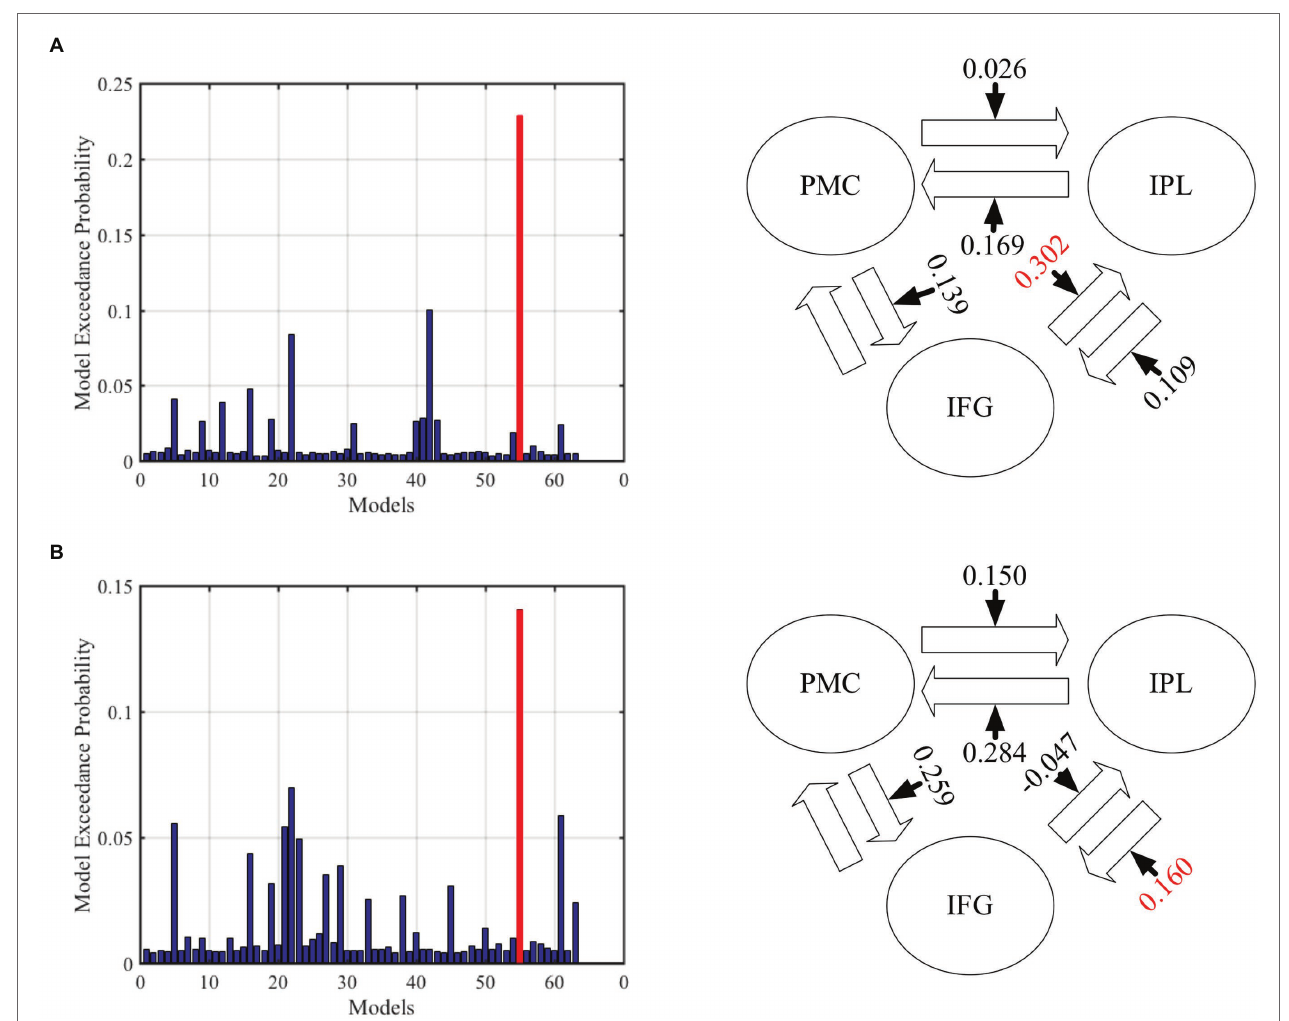
FIGURE 6 | Results of dynamic causal modeling (DCM) analysis across premotor cortex (PMC), inferior frontal gyrus (IFG), and inferior parietal lobule (IPL). (A) The best-fit DCM model with GenA modulatory effect. (B) The best-fit DCM model with GenV modulatory effect. The numbers on the solid arrows indicate the average modulatory effects. The numbers in red indicate that the modulatory effects survive Bonferroni correction for multiple